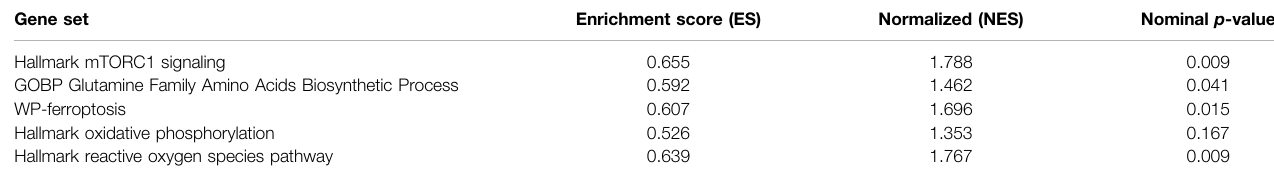
TABLE 4 | The effects of SLC1A5 on the mTORC1 signaling pathway, glutamate metabolism, and ferroptosis process. Gene